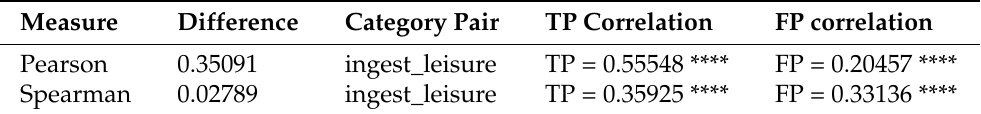
Table 20. Ingest and Leisure in